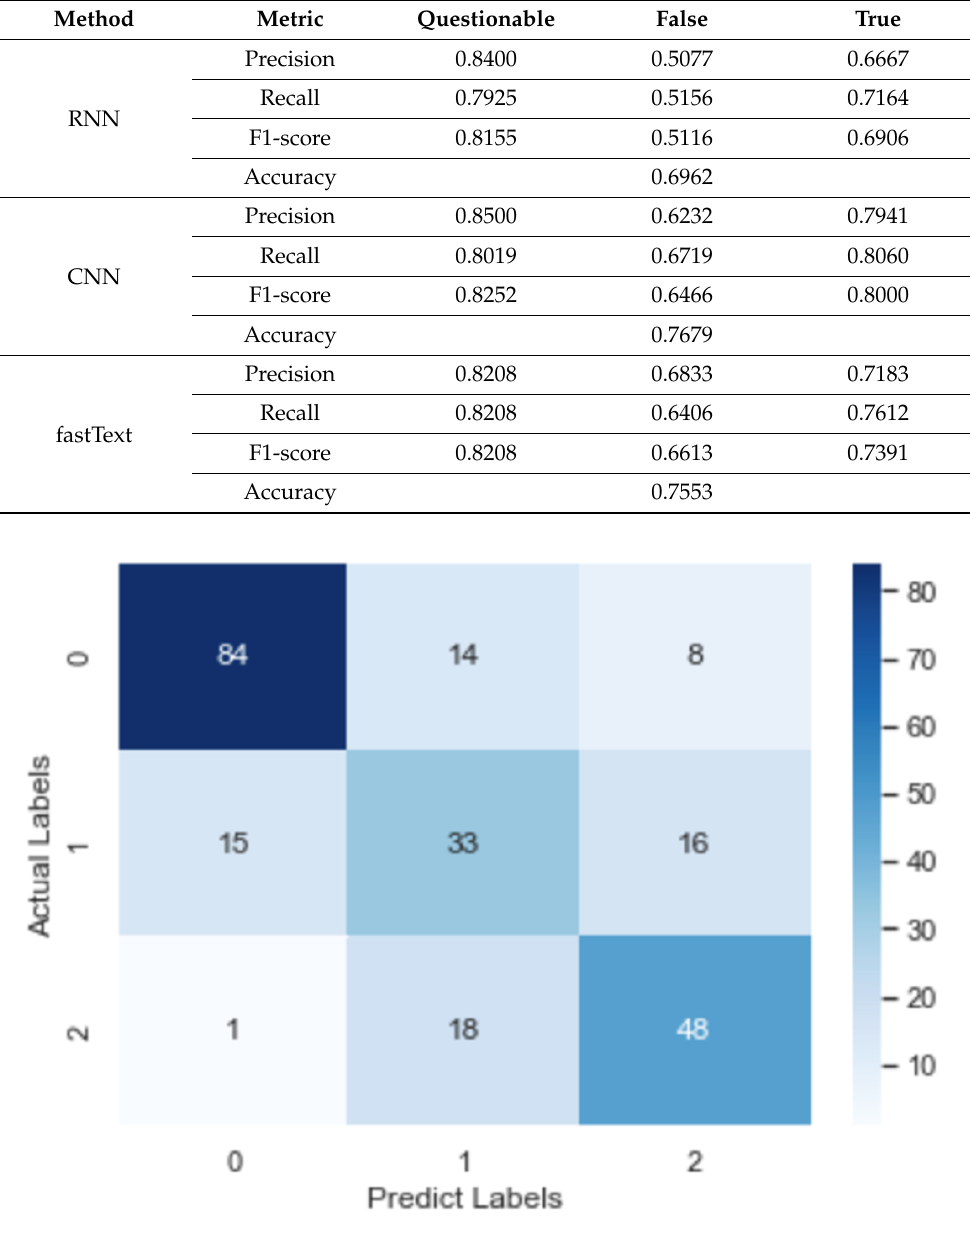
Table 4. Baseline experiment results in misinformation identification using the infodemic 2019 dataset.